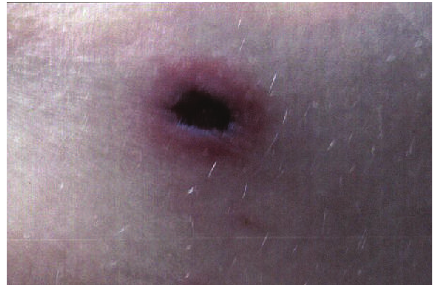
Figure 1: Lesion over the neck.